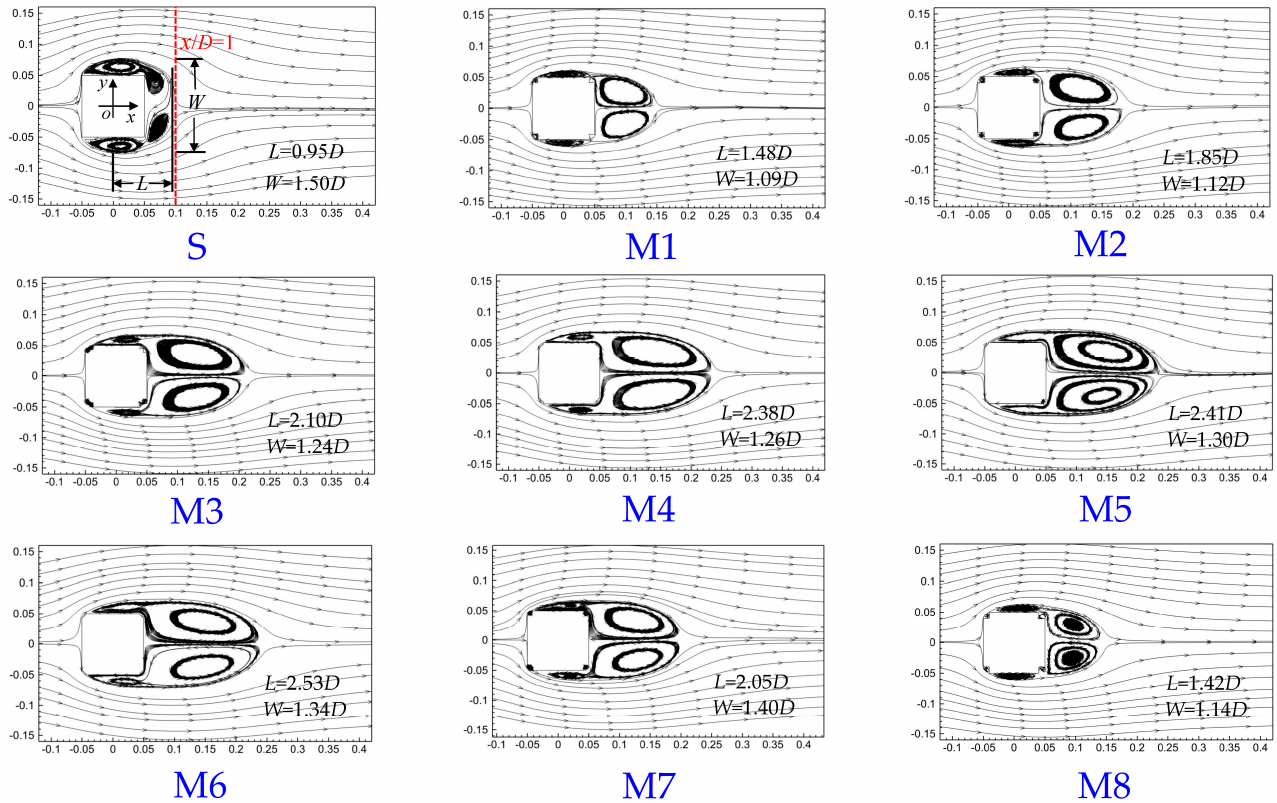
Figure 11. Time-averaged streamlines around different the benchmark section S and the optimal sections M1~M8.